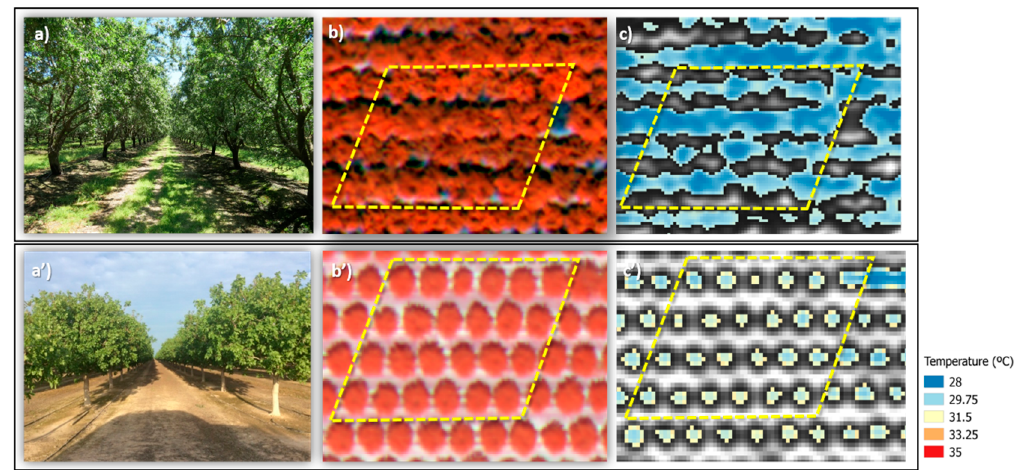
Figure 2. Images from the airborne flight on July 21, 2016 showing the crowns of individual trees in our almond (upper) and pistachio (lower) study plots (yellow trapezoid). Images on the left ( a,a’ ) are RGB photos of the almond and pistachio study orchards, in the middle ( b,b’ ) are false-color near infrared images and images on the right ( c,c’ ) are the thermal images showing the extraction of pure vegetation pixels to estimate canopy temperature.